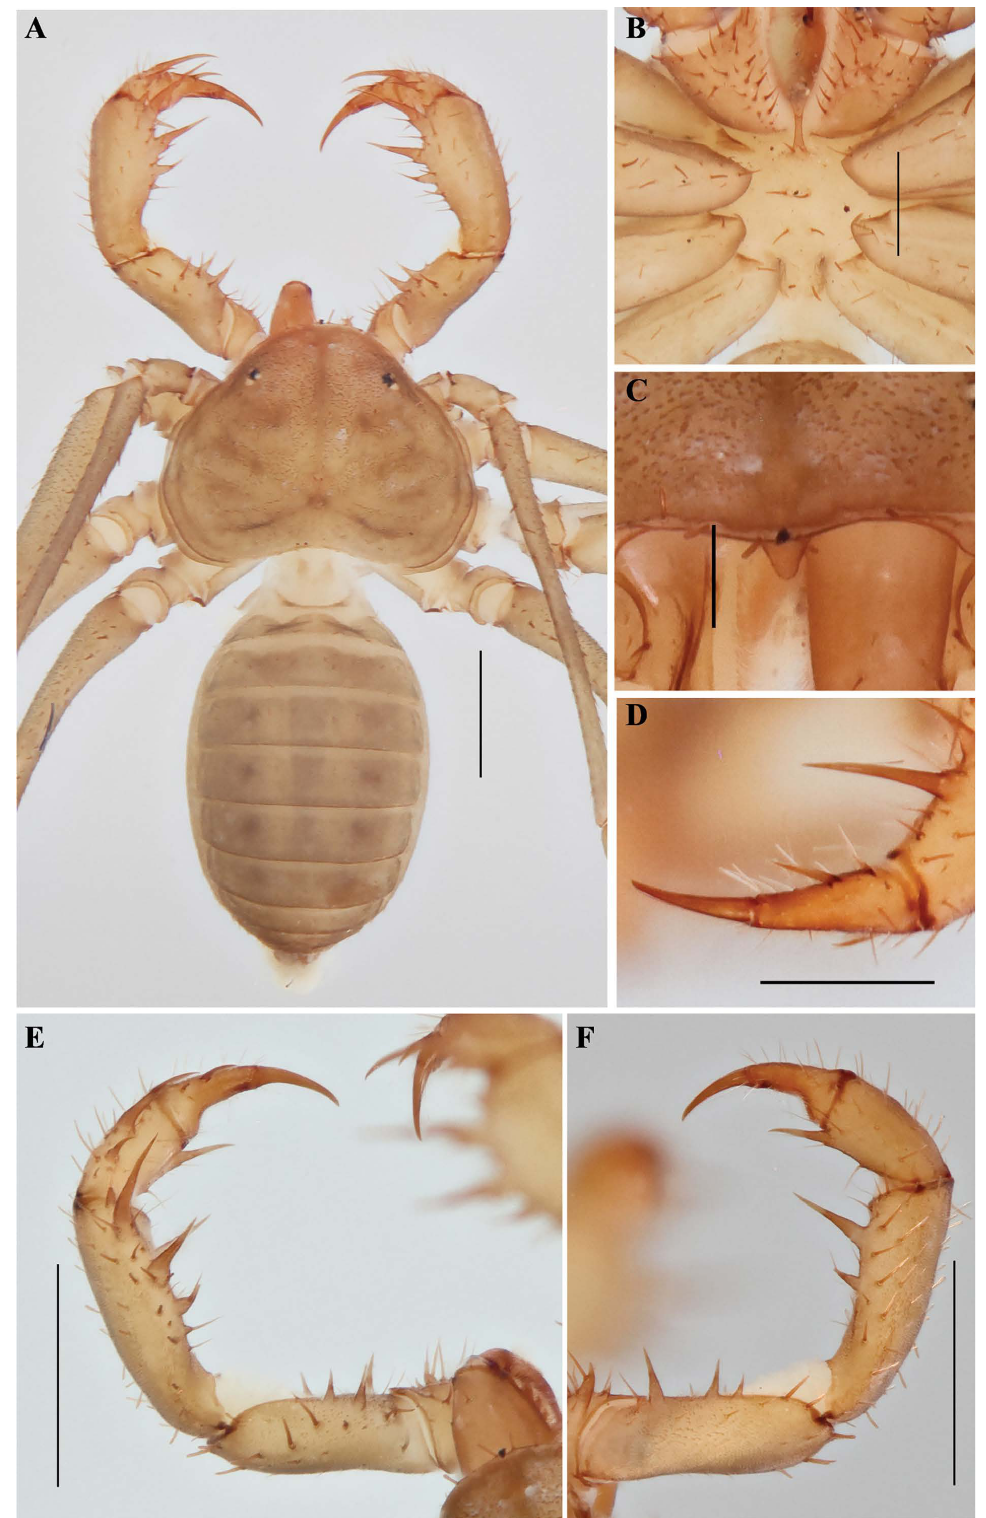
Fig. 30. Charinus magalhaesi sp. nov. (MNRJ 9285), general morphology, ♀. A . Habitus, dorsal view. B . Sternum, ventral view. C . Frontal process. D . Pedipalp tarsus, frontal view. E . Pedipalp, dorsal view. F . Pedipalp, ventral view. Scale bars: A, E–F = 1 mm; B, D = 0.5 mm; C = 0.25 mm.